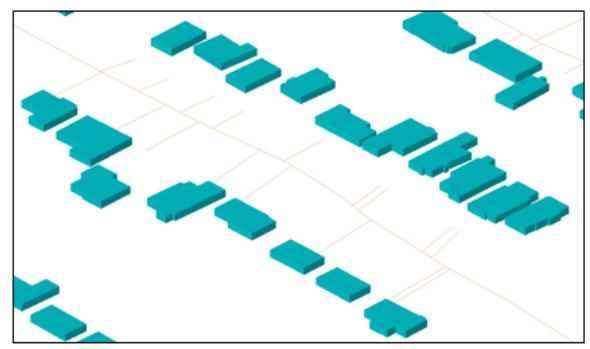
Figure 3. Representation of topography in the Nanaimo water network modelled according to the Utility Network ADE. Figure from “FZK Viewer” software